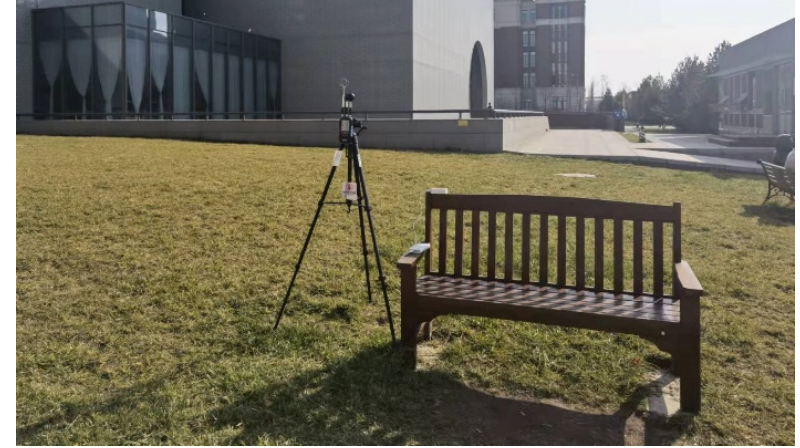
Figure 3. Mean wind speeds measurement.